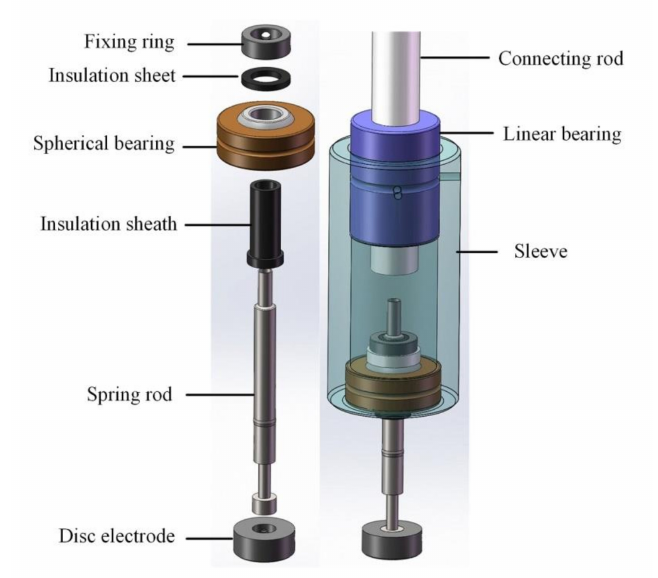
Figure 6. Structure of the upper